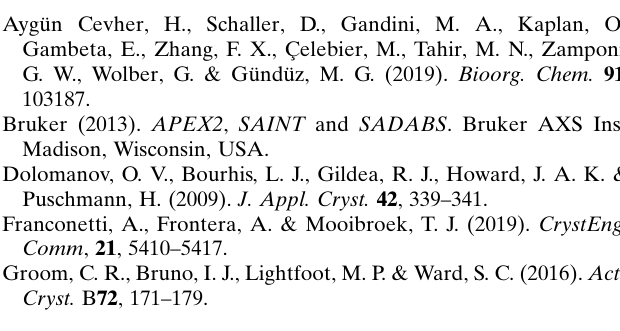
Crystal data Chemical